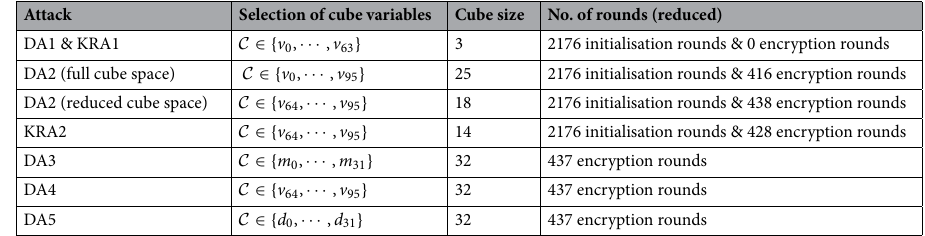
Table 1. Summary of our results. The variables v i , m i , d i are referring to the nonce bits, plaintext bits, and associated data bits,